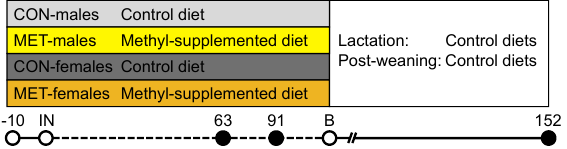
Figure 1. Experimental design. Piétrain gilts were fed either a CON or a MET diet from 10 days before insemination (IN) until tissue sampling at 63 dpc, 91 dpc, and 152 dpn, respectively, when M. longissimus dorsi ( n = 40 per stage) was collected. IN—insemination; B—birth; dpc—days post conception; dpn—days post